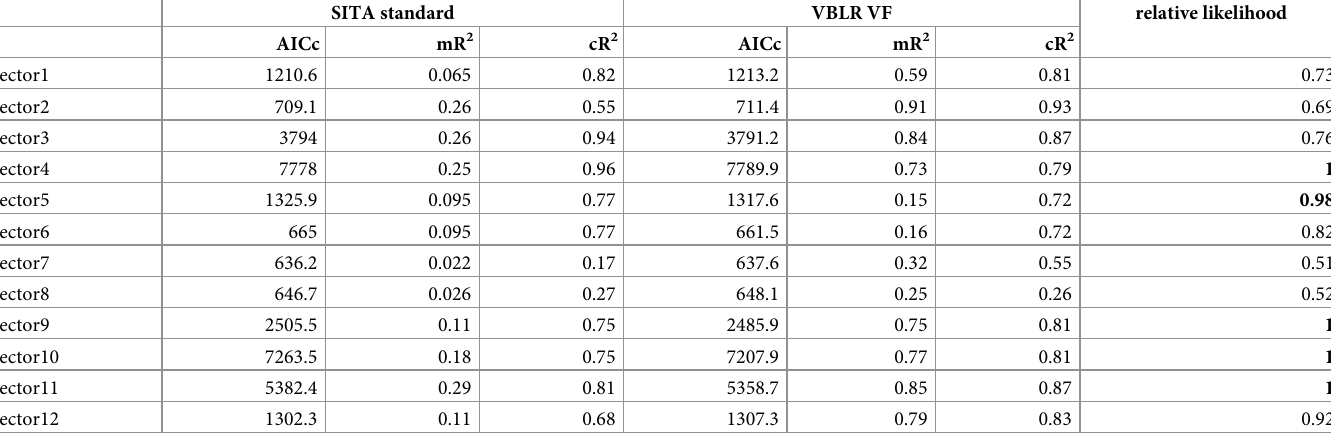
Table 3. Comparison of the values of AICc, mR 2 , and cR 2 , between SITA standard and VBLR-VF. SITA standard VBLR VF relative likelihood